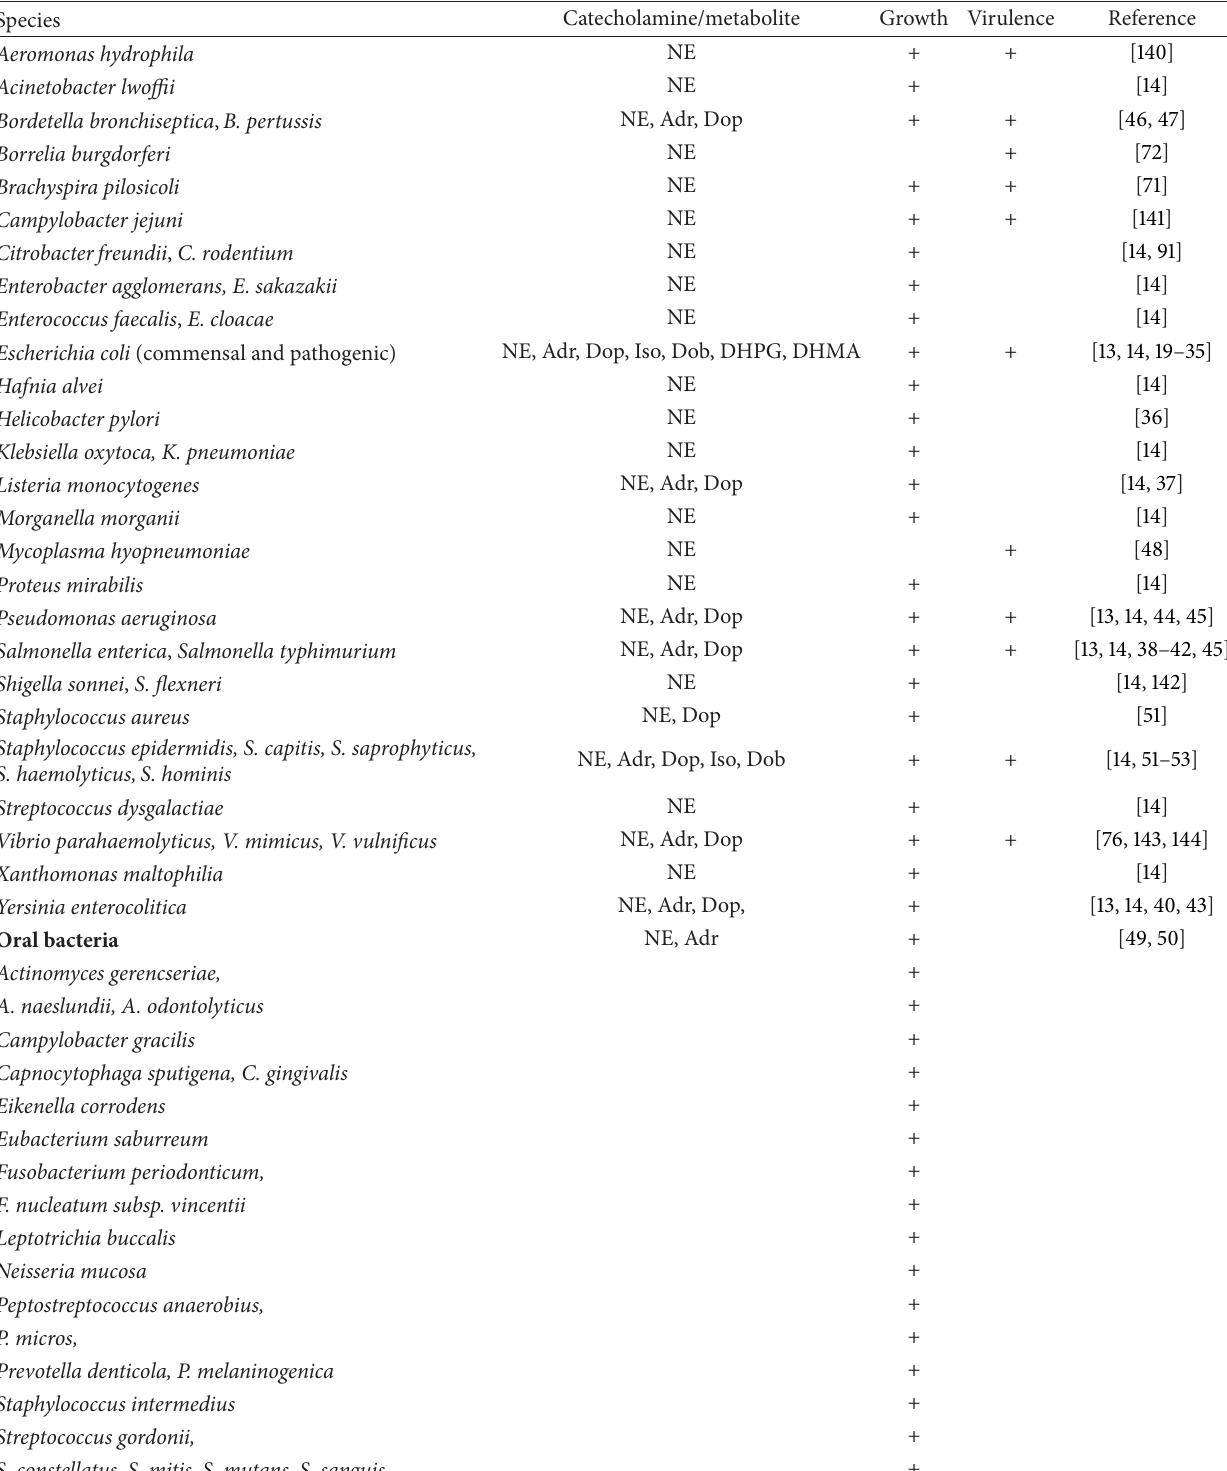
Table 1: Stress hormone responsive